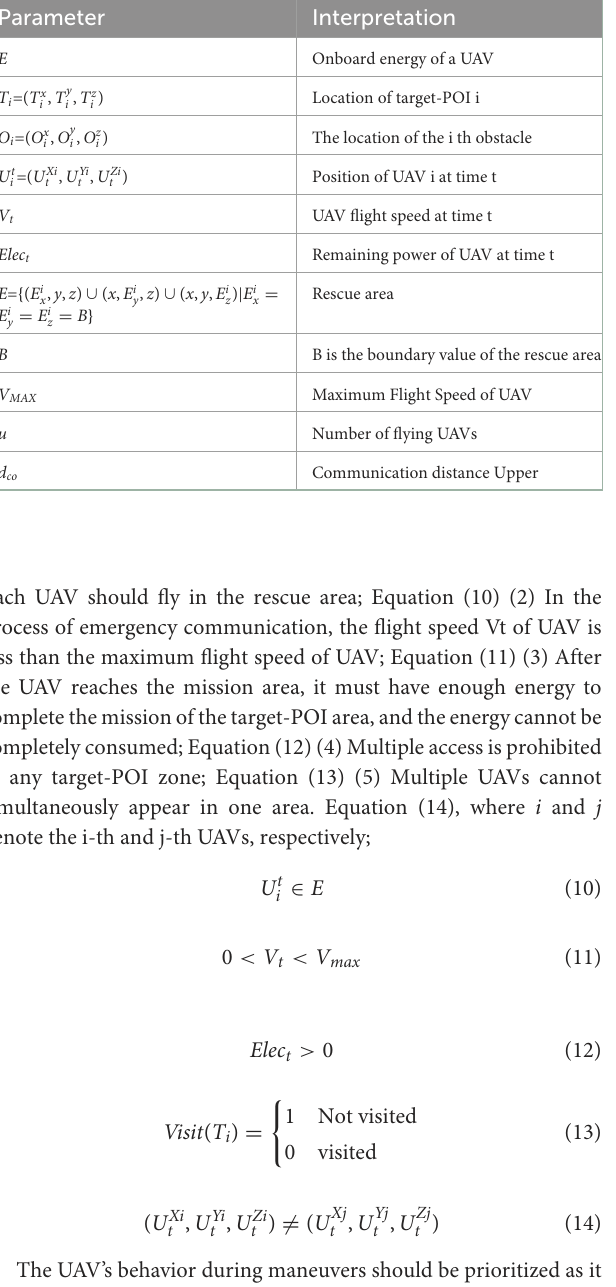
TABLE 1 Statistics of relevant parameters used in multi-UAVs path planning constraint model.